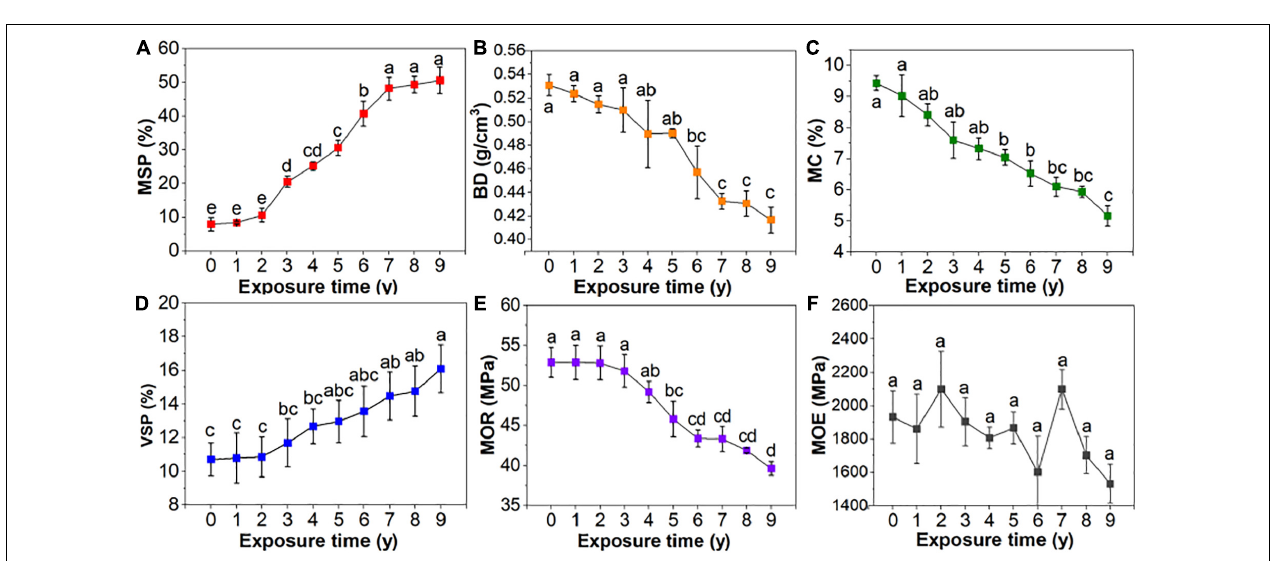
FIGURE 3 | Physical-mechanical properties of Salix psammophila sand barrier. (A) : Mass loss percentage, (B) : Basic density, (C) : Moisture content, (D) : Volumetric shrinkage percentage, (E) : Modulus of rupture, (F) : Modulus of elasticity.